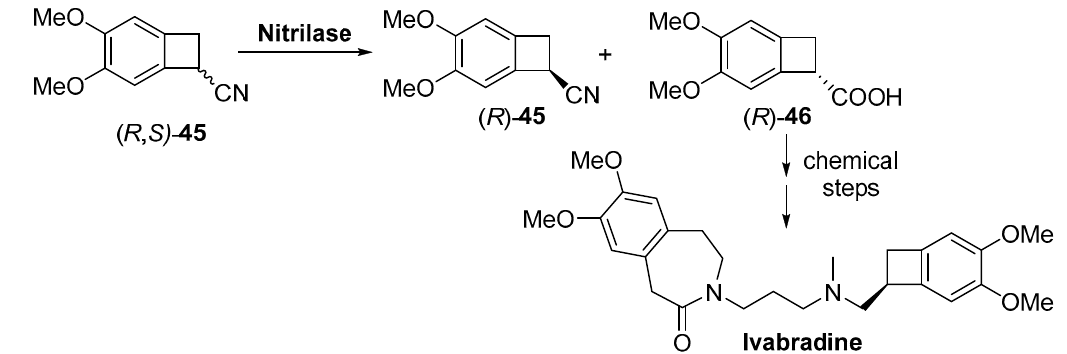
Scheme 18. Synthesis of precursors of the drug ivabradine using